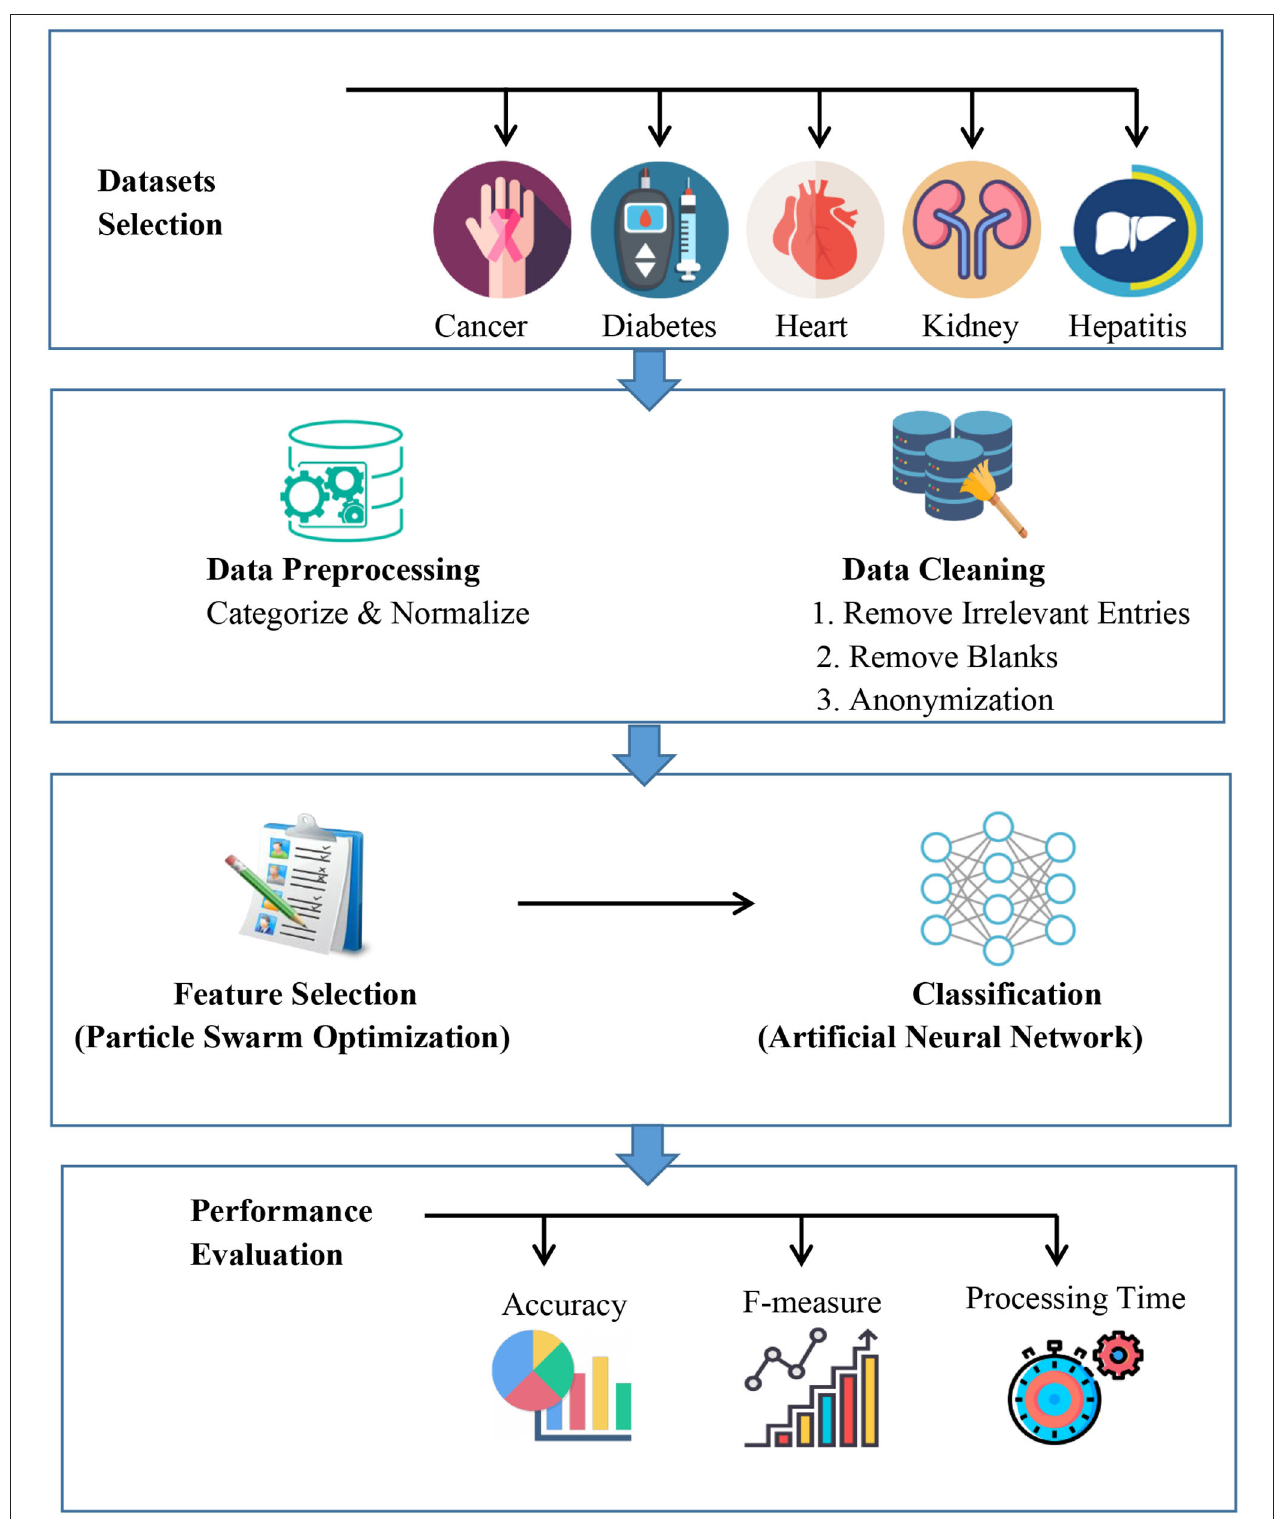
FIGURE 1 | Proposed